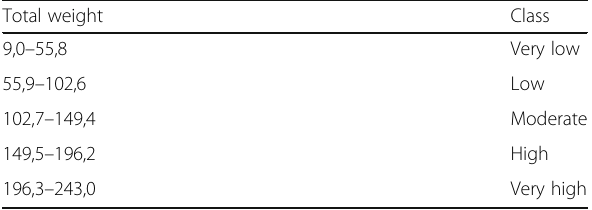
Table 11 The classification of the rockfall hazard